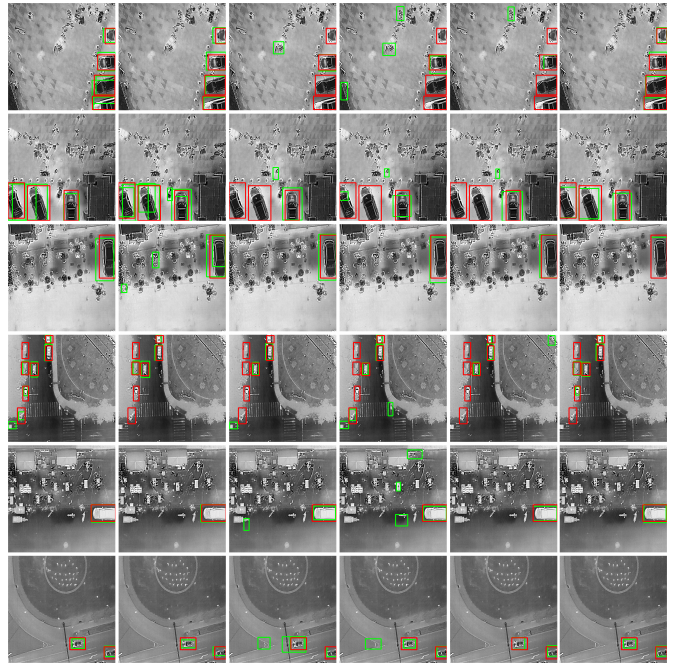
Figure 7. Samples of six fusion models in the infrared images. From left to right are visible, infrared, fusion, BGR, Distangle-oriented and GF-detection. Red box denotes the ground-truth annotation, green is the predicted